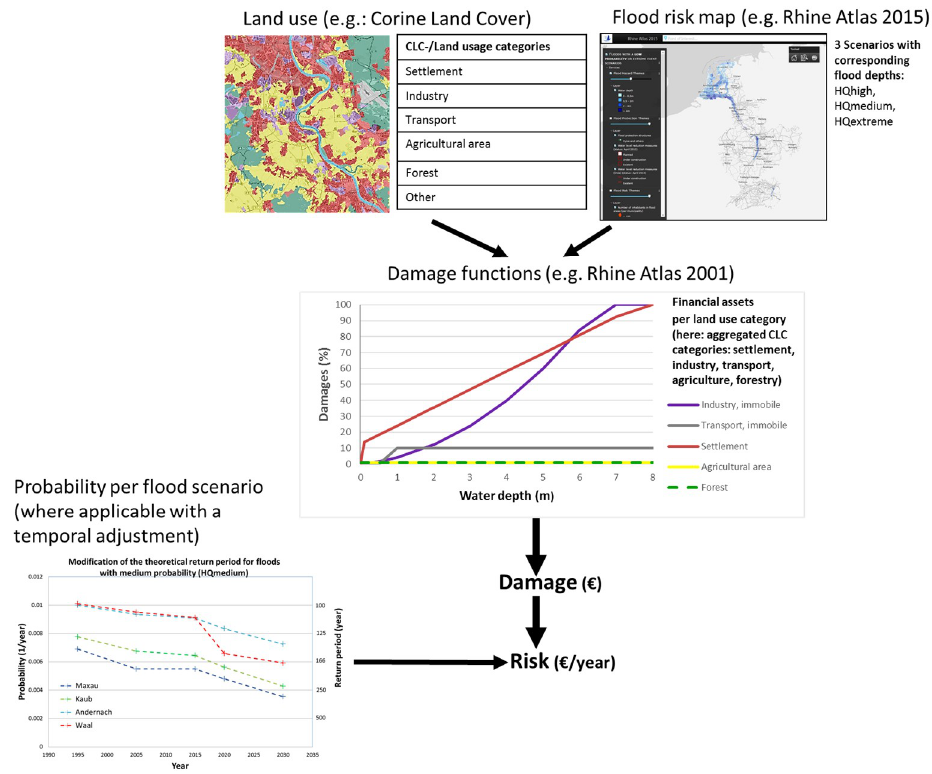
Figure 3. Approach for the analysis of the flood risk upon economic activity [7,8].